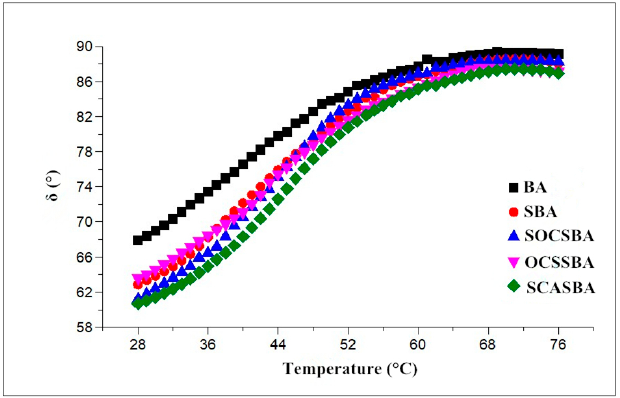
Figure 11. The relationship between complex shear modulus and temperature for modified and unmodified asphalt.